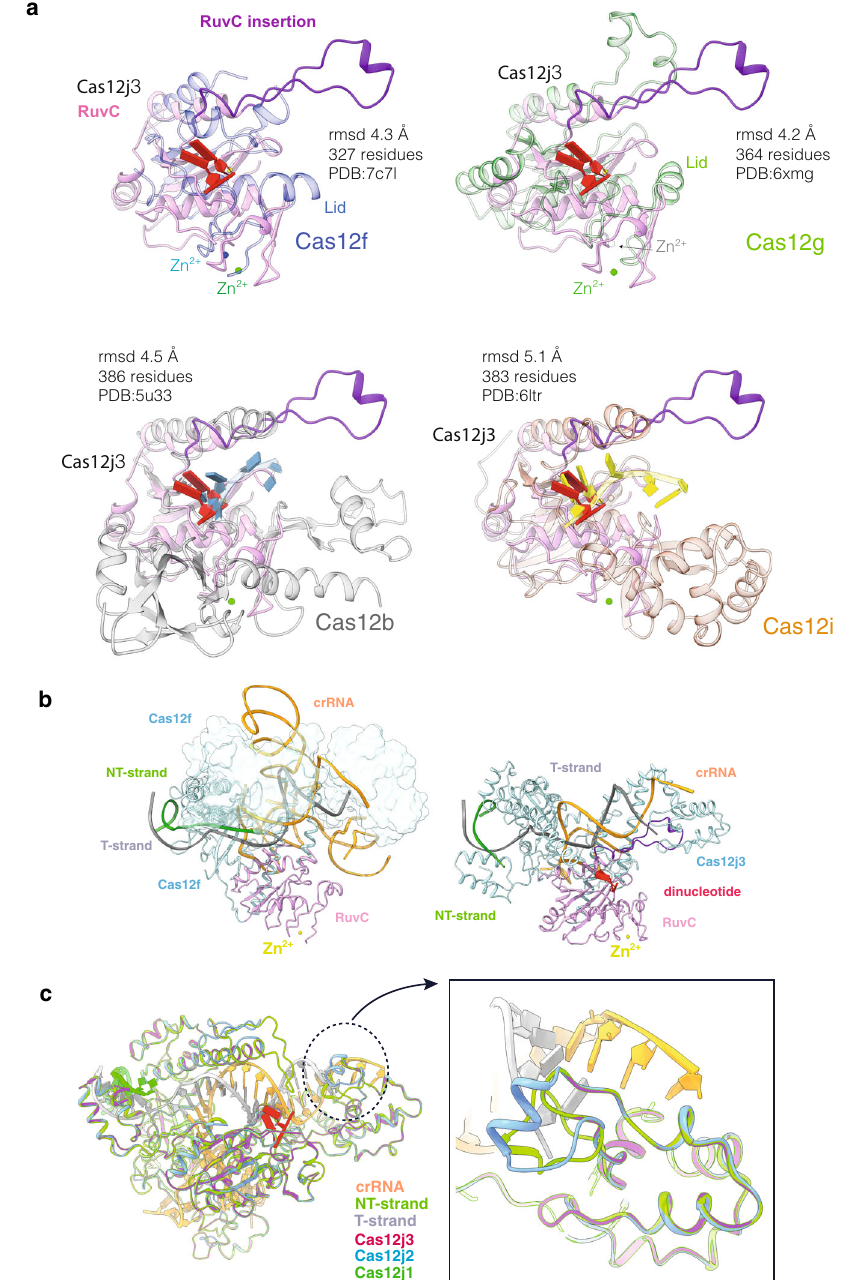
Fig. 6 Structural comparison of Cas12j3 RuvC domain with other Cas nucleases. A structural homology search of Cas12j3 against the PDB was performed using DALI 39 . Only the RuvC domain displays homology with other Cas nucleases. a The top panel shows the superposition of Cas12j3 with Cas12f and Cas12g. Both Cas12f and Cas12g present a Zn 2 + atom coordinated by 4 conserved cysteines as Cas12j3. The rest of the domain is different to the TNB domain in Cas12f and Cas12g. Bottom panel Superposition of Cas12j3 with and Cas12i. Both Cas12b and Cas12i present DNA in the catalytic site and the Nuc domain inserted in the RuvC. b Detailed comparison of Cas12j3 and Cas12f after superposition in the RuvC domain. One of the monomers of the dimeric Cas12f is shown in surface representation for clarity. c Homology modelling of Cas12j1 and Cas12j using Cas12j3 and superposition of the three Cas12j family members. The inset shows the differences in the STP